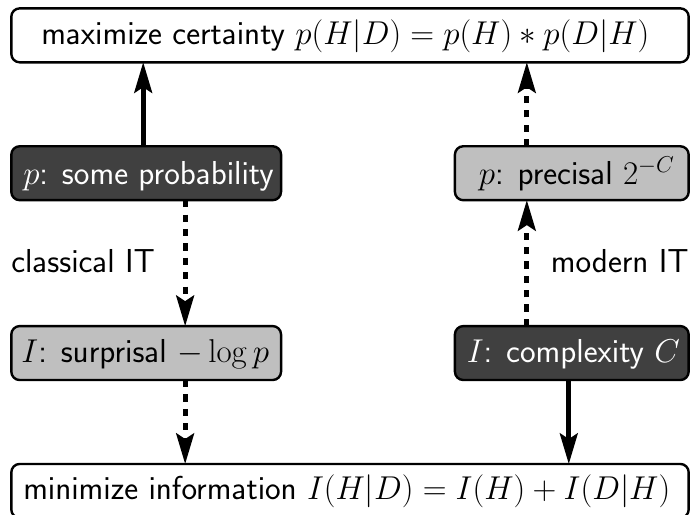
Figure 3. Surprisals versus precisals. For data D and hypotheses H , probabilities p can be used to maximize Bayesian certainty under these probabilities (top left), and via the surprisal conversion I = log p , also to minimize information as quantified in classical information theory (IT) (bottom − left). Descriptive complexities C can be used to minimize information as quantified in modern IT (bottom right), and via the precisal conversion p = 2 − C , also to maximize Bayesian certainty under these precisals (top right) (adapted from